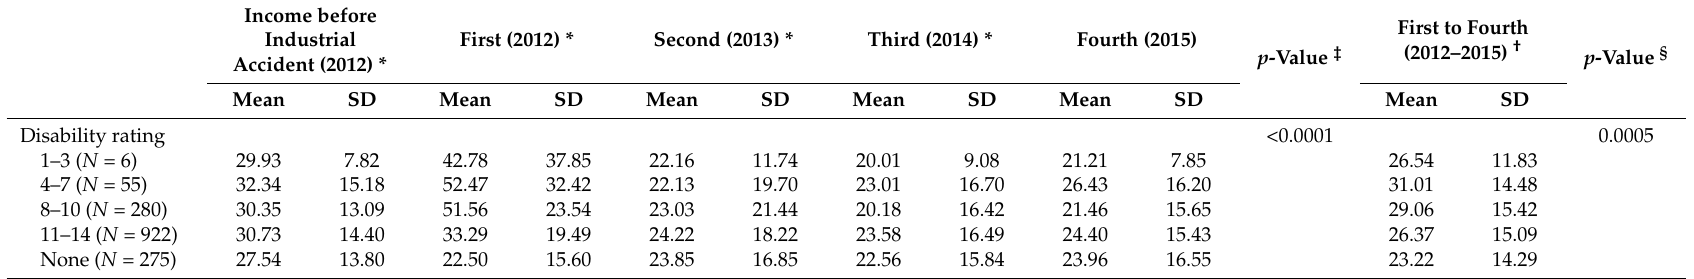
Table 2. Relationship between disability rating and annual income changes before and after industrial accident (unit: million KRW).